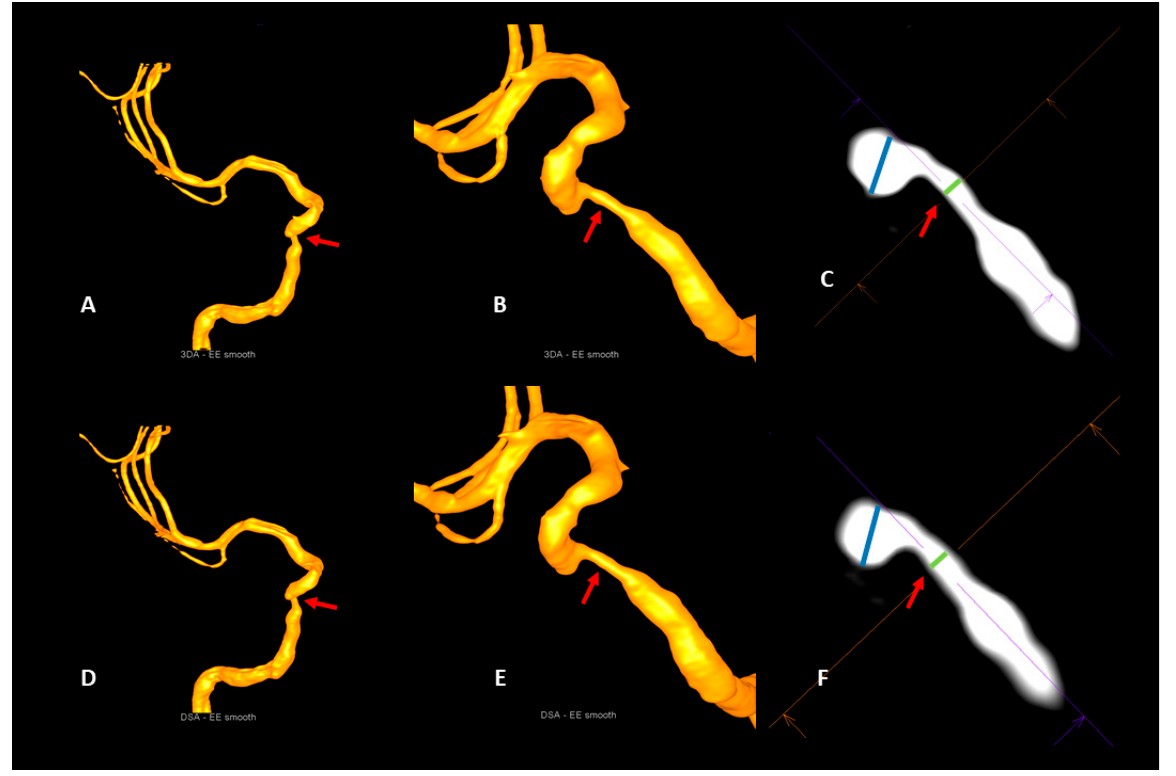
Figure 3. Illustrative case 2. Visualization of a stenosis of the cavernous segment of the right internal carotid artery (red arrows) with the artificial intelligence-based 3DA ( A – C ) and 3D-DSA ( D – F ). Comparable with 3D-DSA ( D , E ), 3DA ( A , B ) provides a clear visualization of the stenosis (red arrows) in the volume-rendered reconstructions. The measurements of the intra- and poststenotic diameters in multiplanar reconstructions of 3DA ( C ) and 3D-DSA ( F ) do not show a relevant deviation from each other. As a consequence, the calculation of the percentual degrees of luminal restriction in the 3DA (NASCET 3DA = 70.5%) and the 3D-DSA (NASCET 3D-DSA = 69.5%) reconstruction shows a strong accordance.